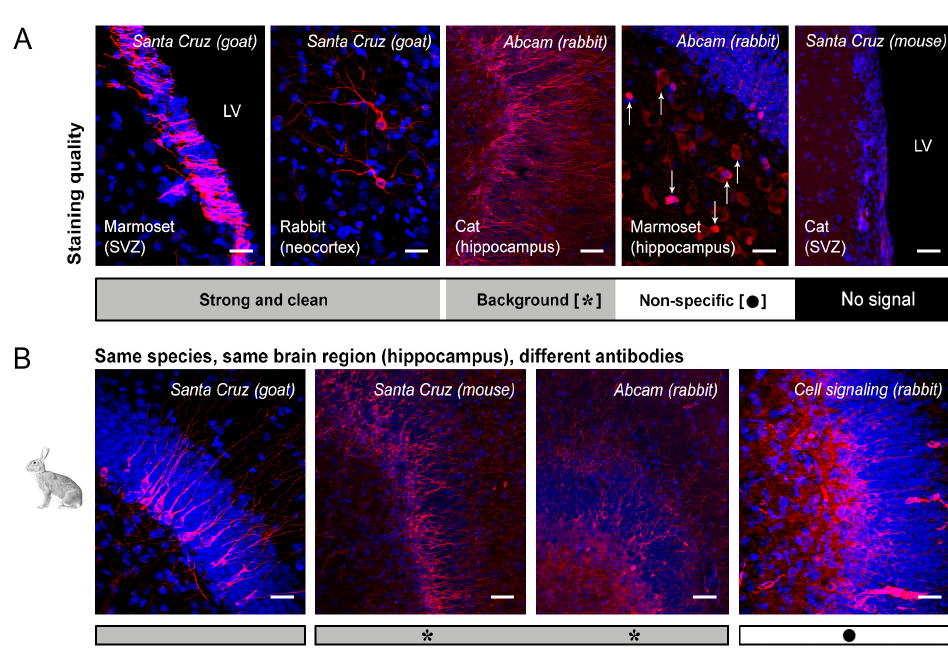
Figure 4. Type and quality of immunostaining obtained with different antibodies in different animal species and brain regions. ( A ) Four types of staining were considered, including a clear and clean staining without background noise, a specific staining bleary with background, an unspecific staining (with or without background; including artifacts, or staining associated with other structures, e.g., blood vessels, astrocytes, other neurons), and the absence of signal. Bottom: legend with symbols reported in the Results Tables. ( B ), Some examples considering substantial differences depending on the different antibodies used. LV: lateral ventricle. Scale bars: 30 µm.